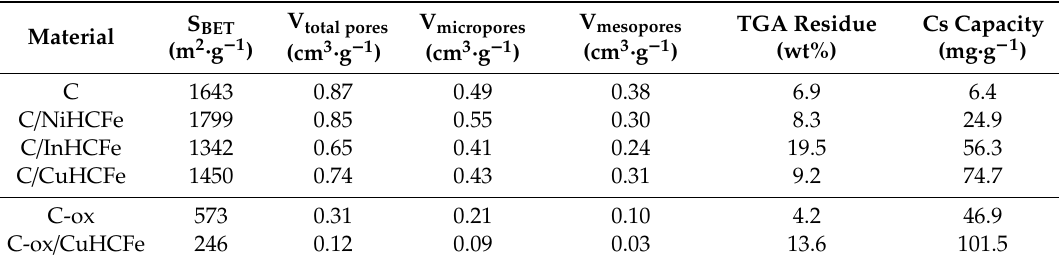
Table 1. Textural characteristics of carbon supports and C / MHCFe nanocomposites extracted from nitrogen adsorption isotherms; the amount of metal-oxide residue obtained using TGA analyses and Cs adsorption